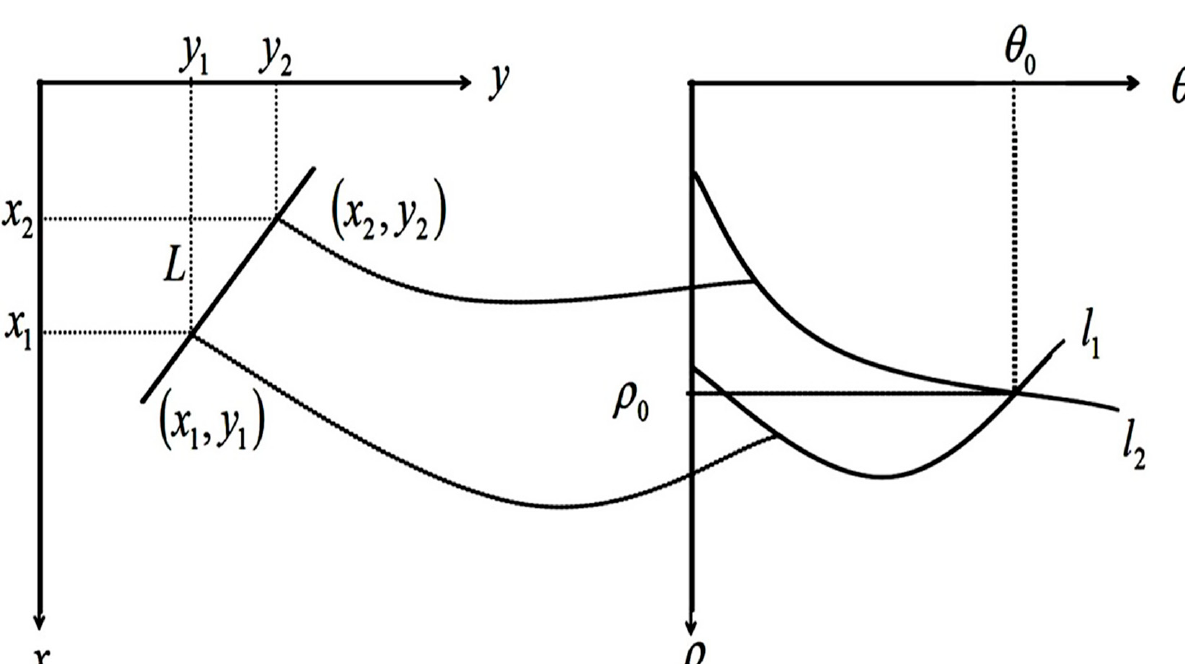
Figure 10. Geometric parameters and Hough space depicted schematically.